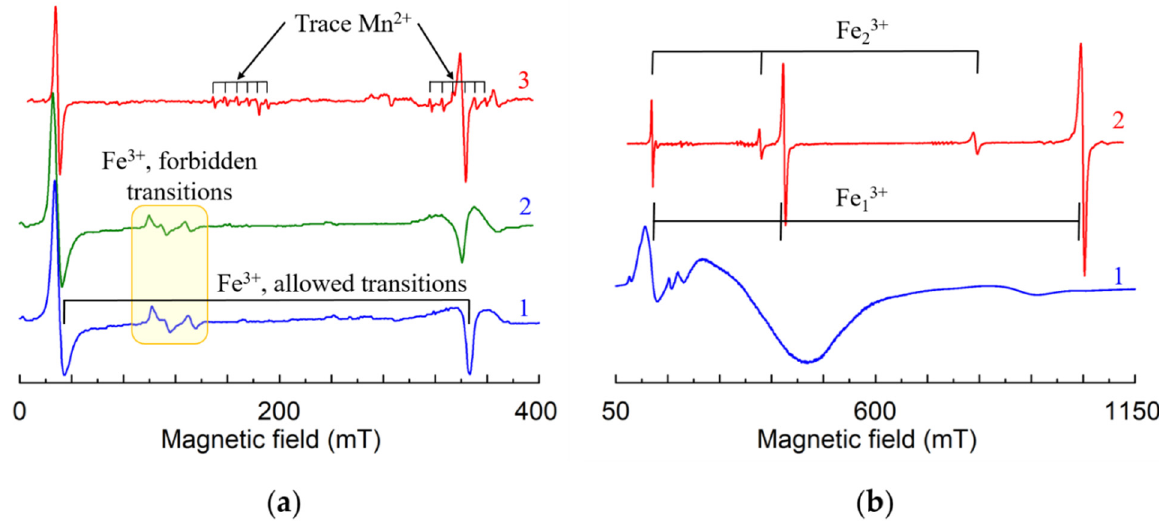
Figure 18. Normalized spectra of Fe 3+ in LN ( a ) and LT ( b ), X-band. ( a ) Congruent (1), grown with x m = 0.545 (2), undoped sample grown from congruent the melt with 6 wt% of K 2 O (3), B||z . ( b ) Congruent (1), vapor transport equilibrium (VTE) treated sample (2), B || x .